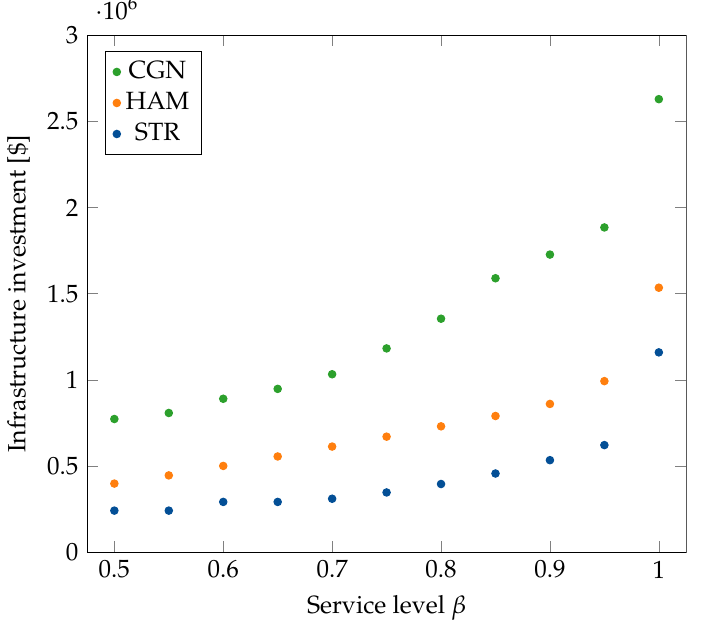
Figure 8. Variation of service level β in large instances (Time limit: